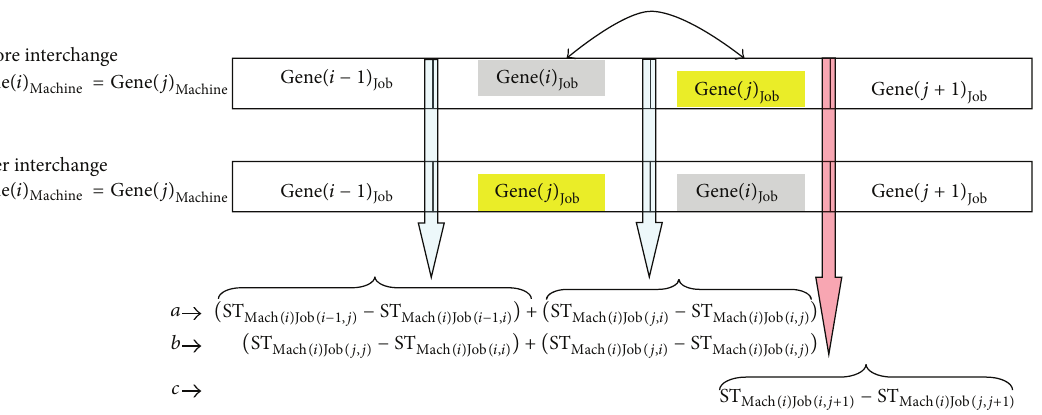
Figure 5: Intermachine interchange and adjacent jobs situation.